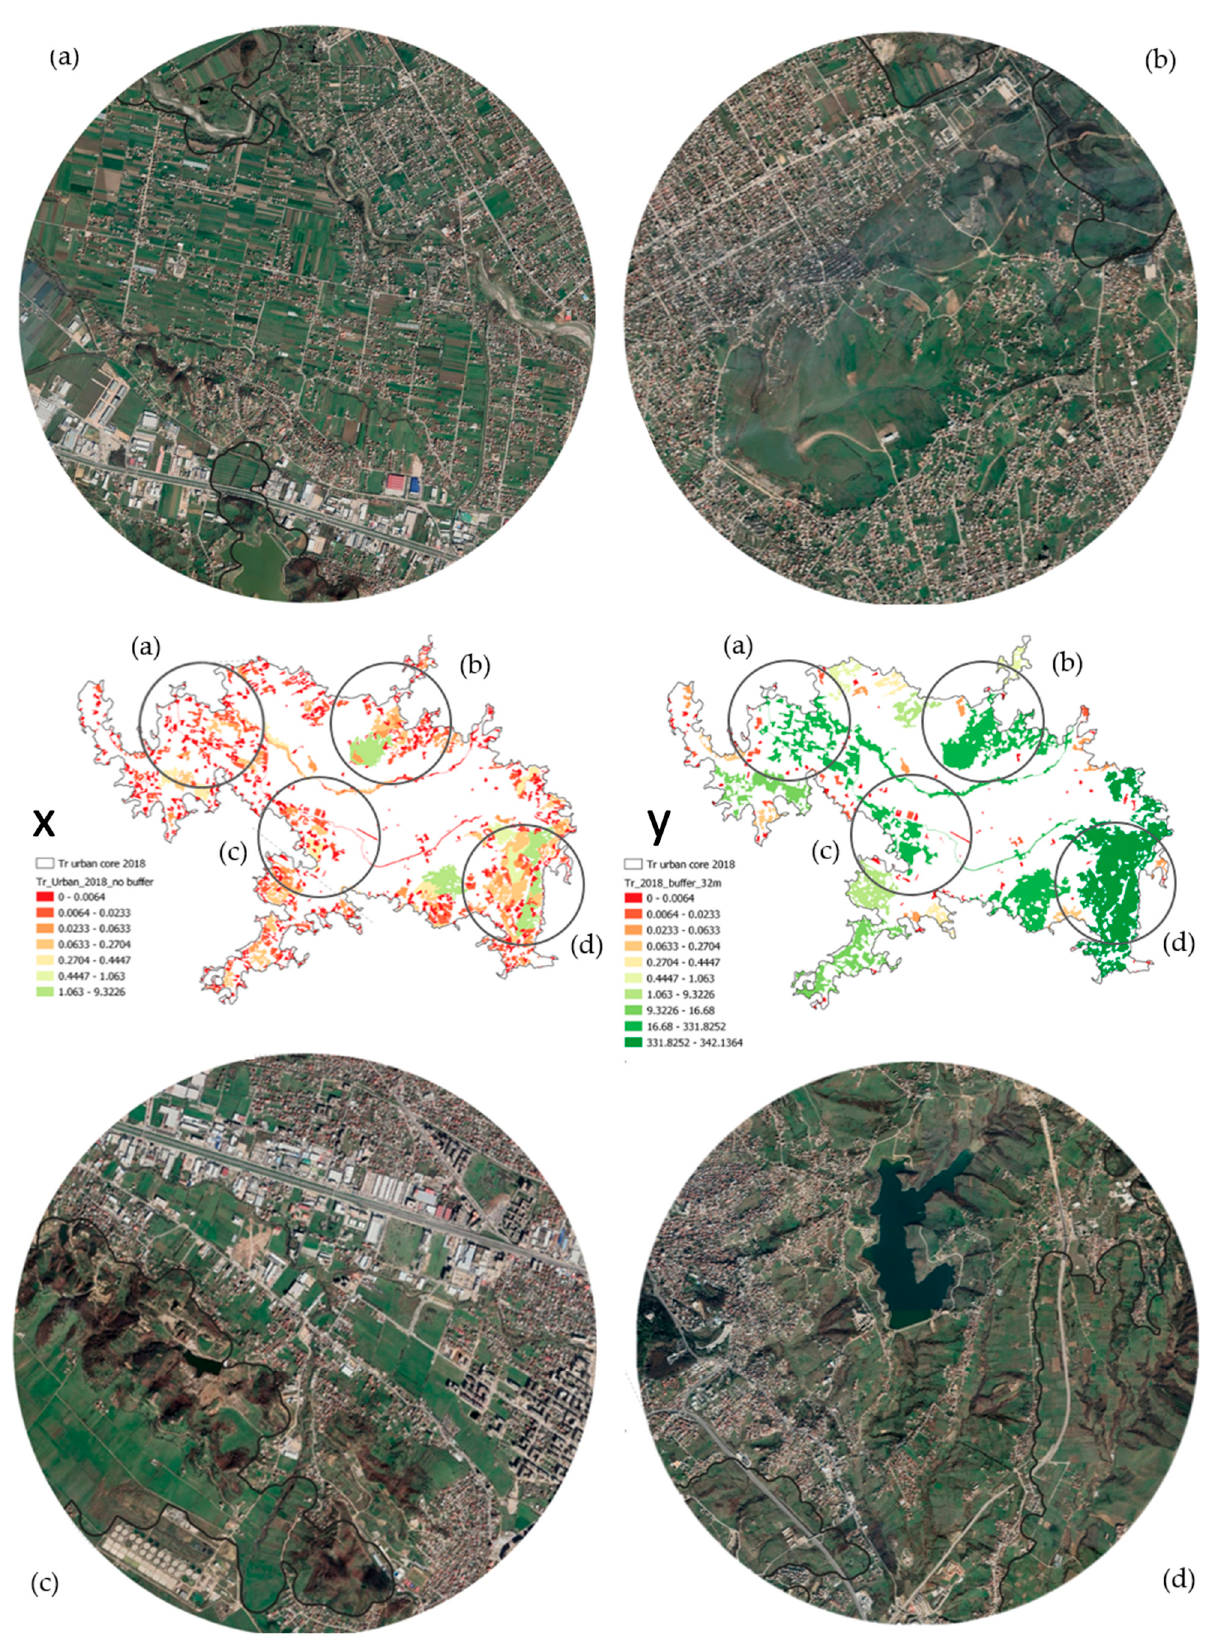
Figure 9. Zoomed-in spots: ( a ) Domje-Bërxull, ( b ) Paskuqan, ( c )Yzberisht-Mezez, and ( d ) Shkoze- Farke-Lunder.